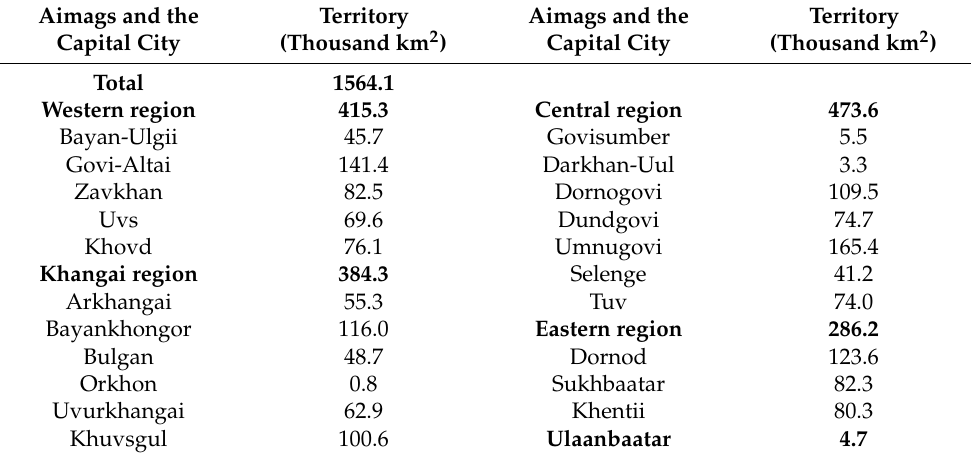
Table 2. Mongolian provinces and